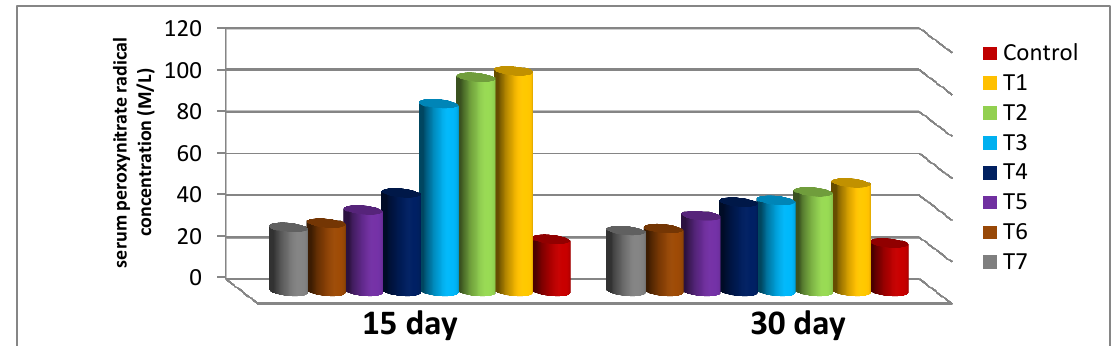
Figure 5: Effect of different doses of total polyphenol extracted from green tea for 15 and 30 days on serum peroxynitrite radical concentration (M/L) of iron overload treated